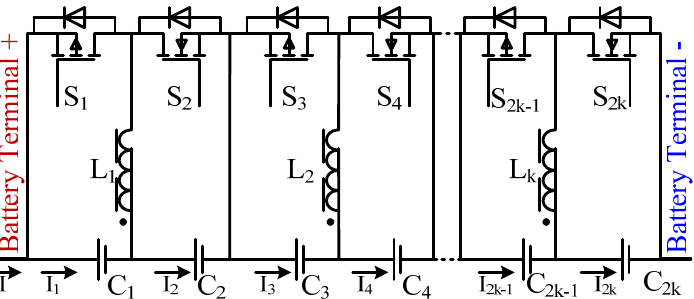
Figure 2. The proposed bidirectional flyback converter balancing